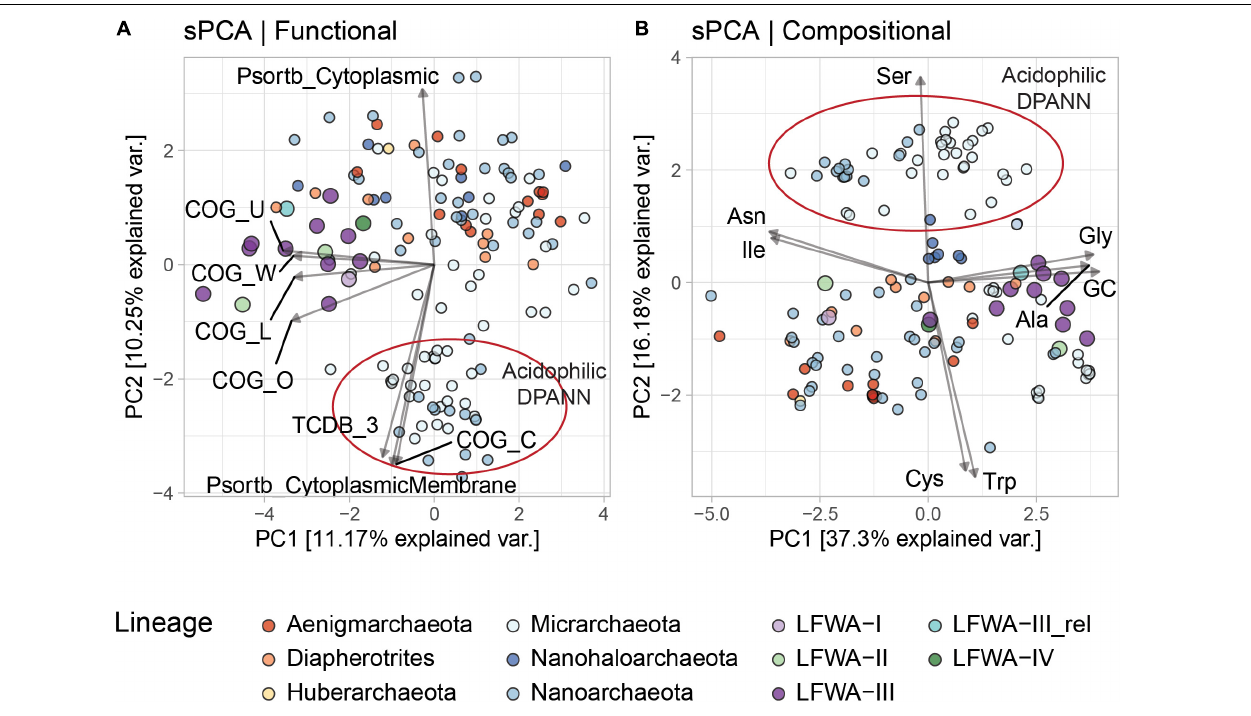
FIGURE 5 | sPCA analysis of the functional (A) and compositional (B) features in DPANN genomes. Only explanatory variables correlated at absolute value of ≥ 0.75 with the principal components are shown. Variables are scaled (4x) for easier visualization. MAGs from LFLS lineages are displayed with larger circles.